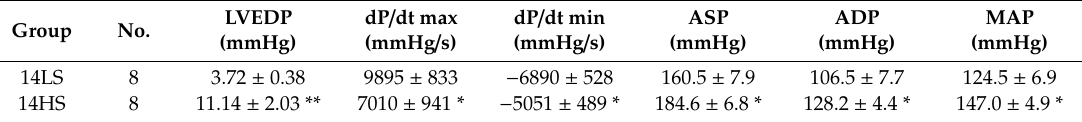
Table 2. Hemodynamic parameters in HS and LS groups at the age of 14 weeks.